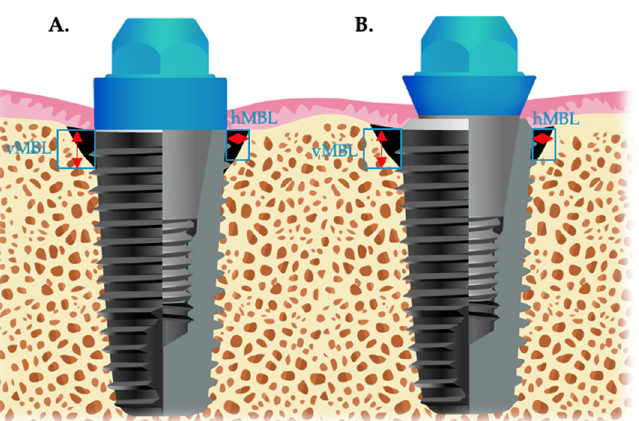
Figure 2. Radiographic measurements of the platform-switched and platform-matched dental implants. ( A ) Platform-matched dental implants (PM). ( B ) Platform-switched dental implants (PS). vMBL, vertical marginal bone level; hMBL, horizontal marginal bone level.